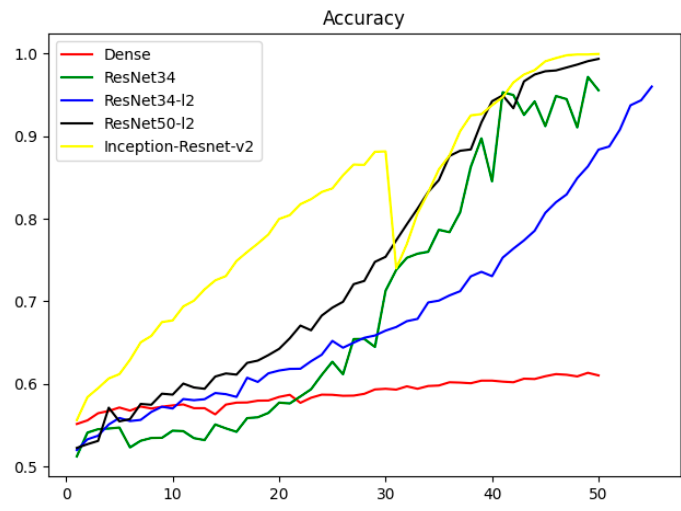
Figure 1. Comparison of the models in the X-ray classification task.